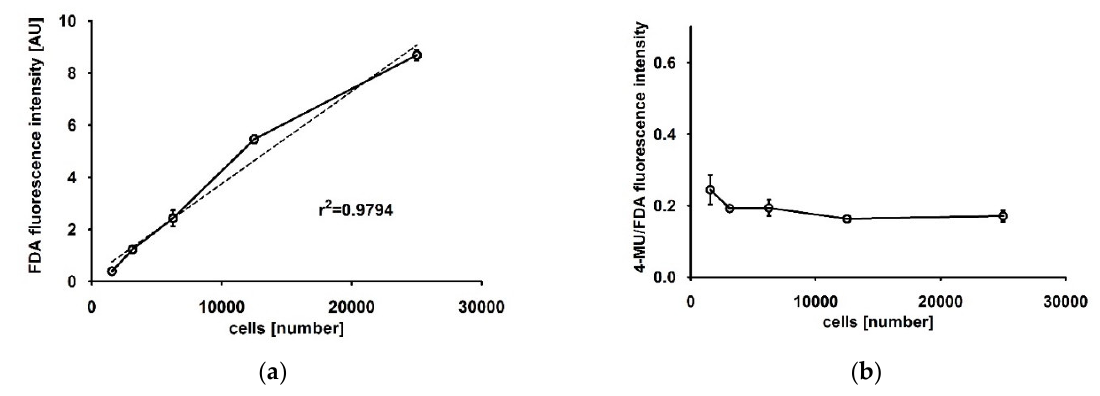
Figure 3. ( a ) Fluorescein–diacetate (FDA) fluorescence intensity for 1563, 3125, 6250, 12,500 and 25,000 HOS cells. The dotted line indicates the linear regression curve with r 2 = 0.9794. ( b ) 4-methylumbelliferone (4-MU) / FDA fluorescence intensity ratios calculated from 1563, 3125, 6250, 12,500 and 25,000 HOS